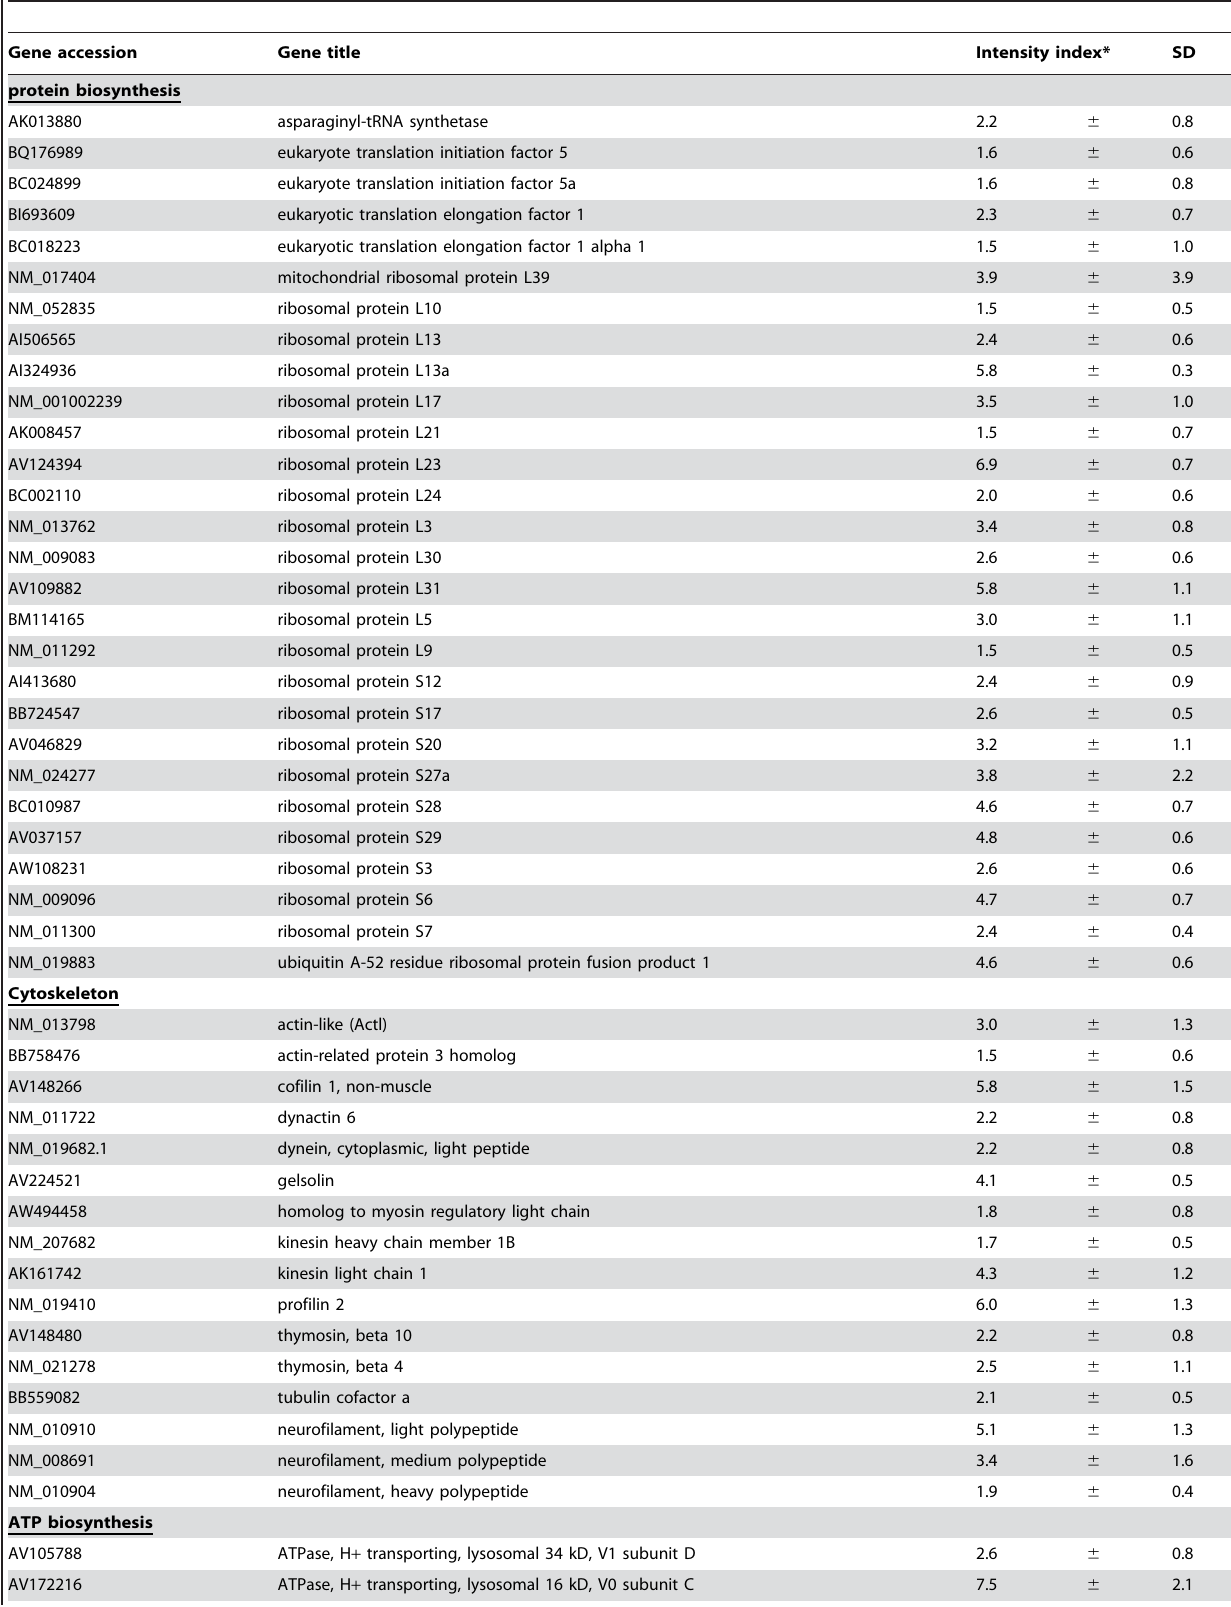
Table 1. List of highly oxidized mRNA species in the spinal cord of 60 day-old SOD1 G93A mice.